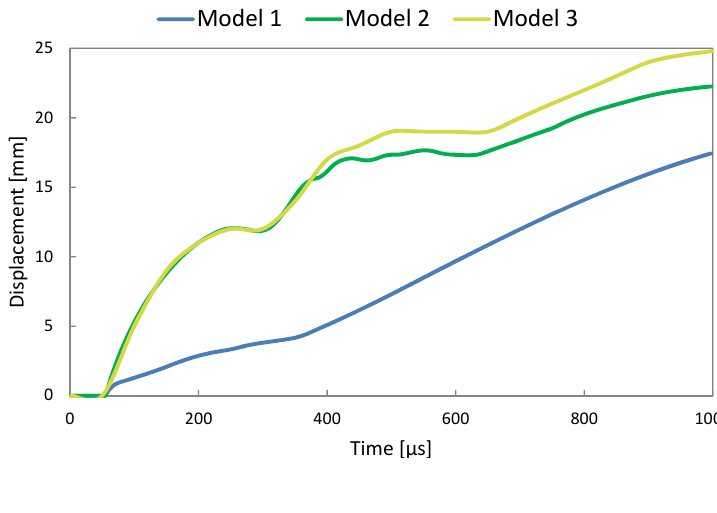
Figure 6. Average vertical displacement of the top surface of the aluminum